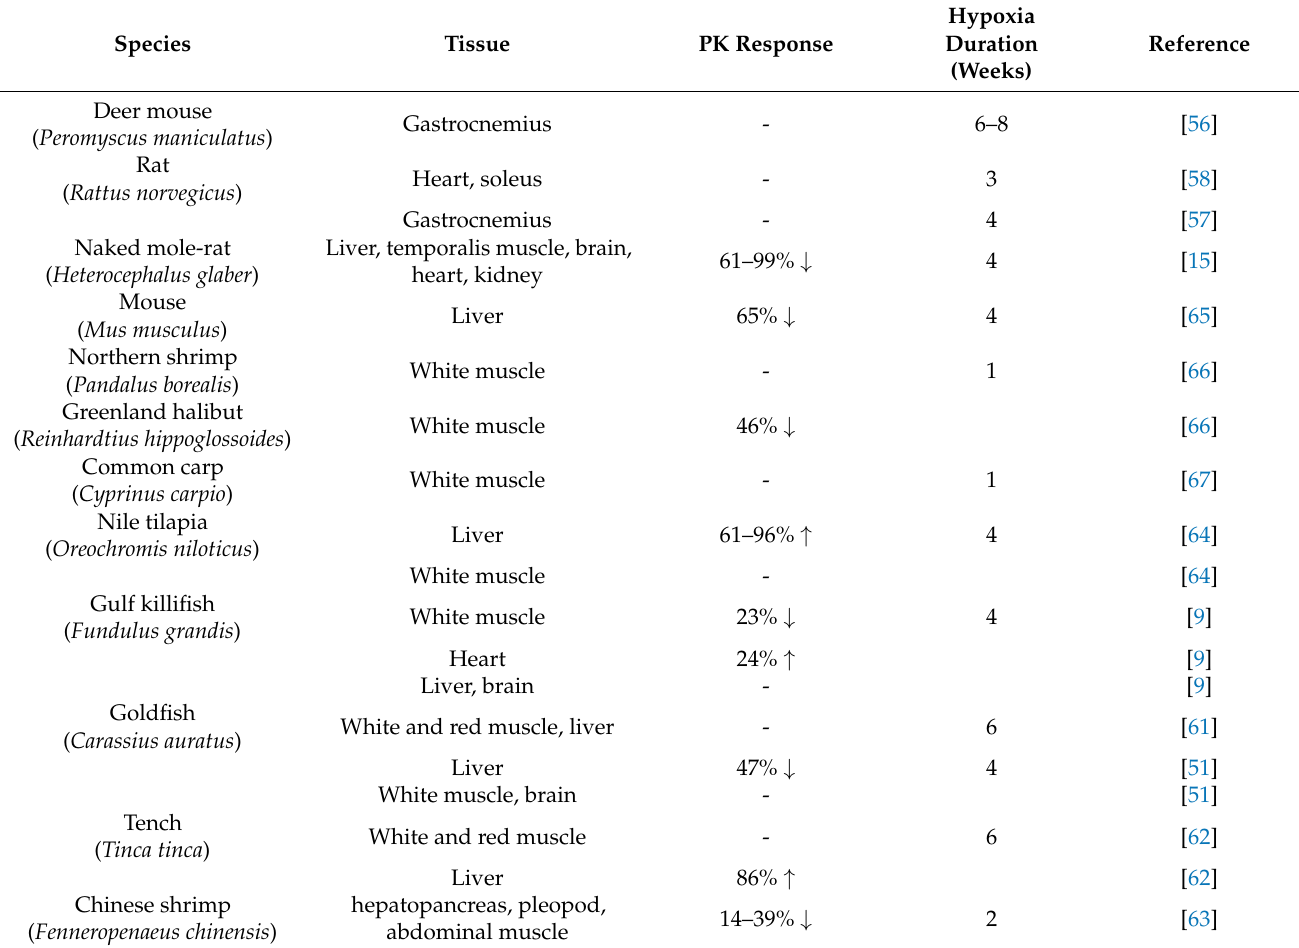
Table 4. Effects of chronic hypoxia (minimum 1 week) on the maximal activity of pyruvate kinase (PK) in various animals.